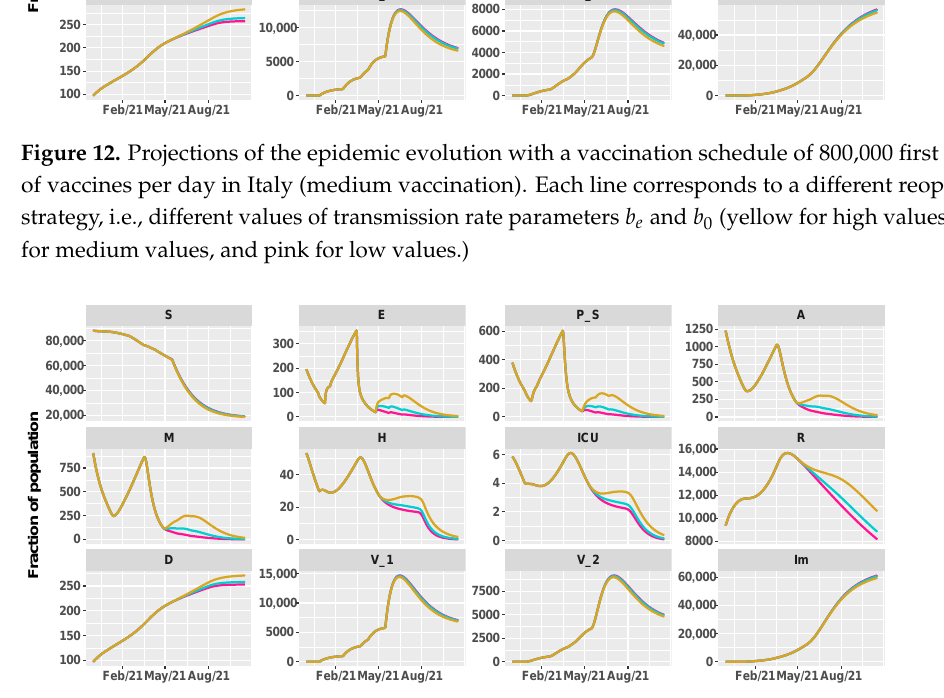
Figure 13. Projections of the epidemic evolution with a vaccination schedule of 1,000,000 first doses of vaccines per day in Italy (fast vaccination). Each line corresponds to a different reopening strategy, i.e., different values of transmission rate parameters b e and b 0 (yellow for high values, blue for medium values, and pink for low